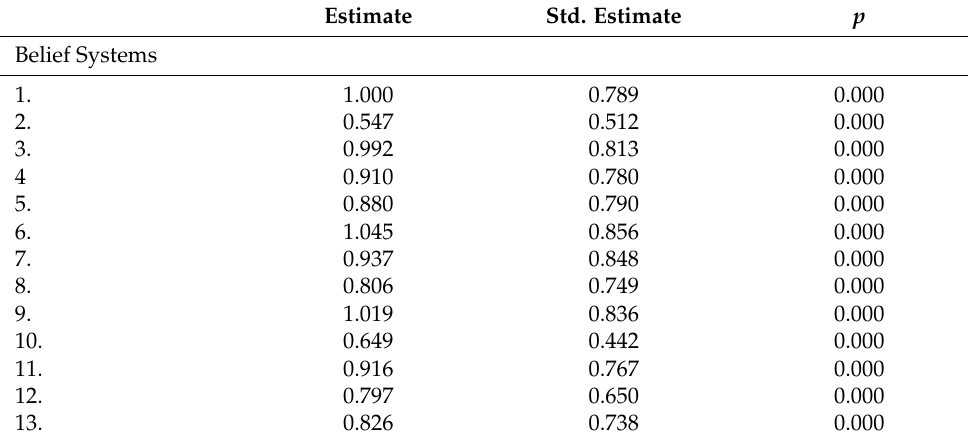
Table 3. Factor loadings for